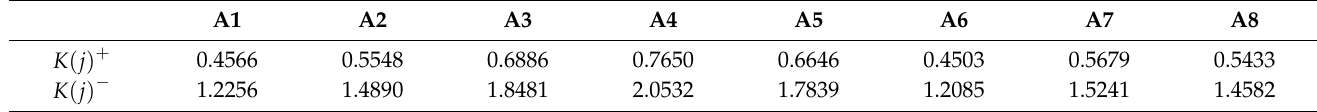
Table 6. Utility degree of the ideal and anti-ideal solution of various market-oriented